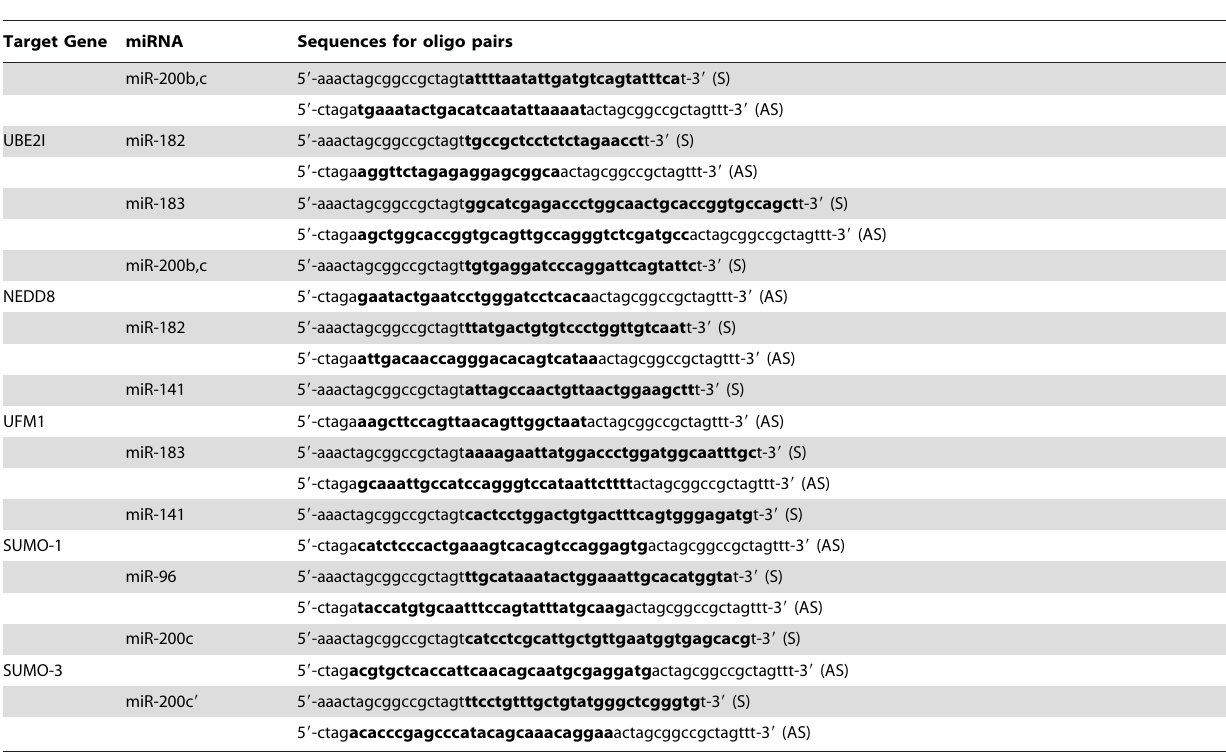
Table 1. Oligonucleotides used for reporter plasmid construction (Predicted miR target sequences in each gene are shown in bold